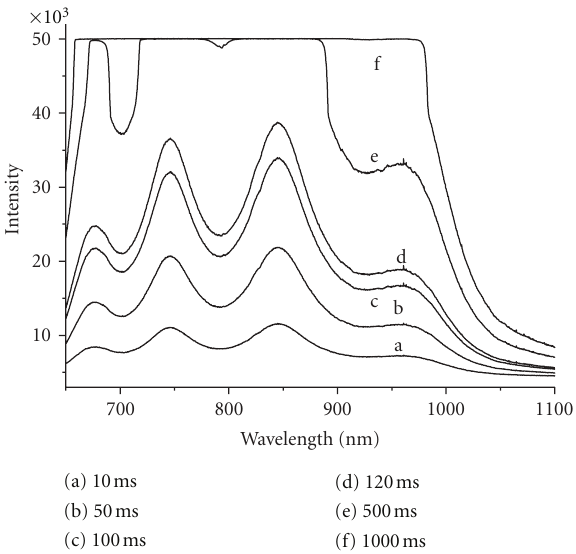
Figure 2: Light source spectra recorded for di ff erent integration times.